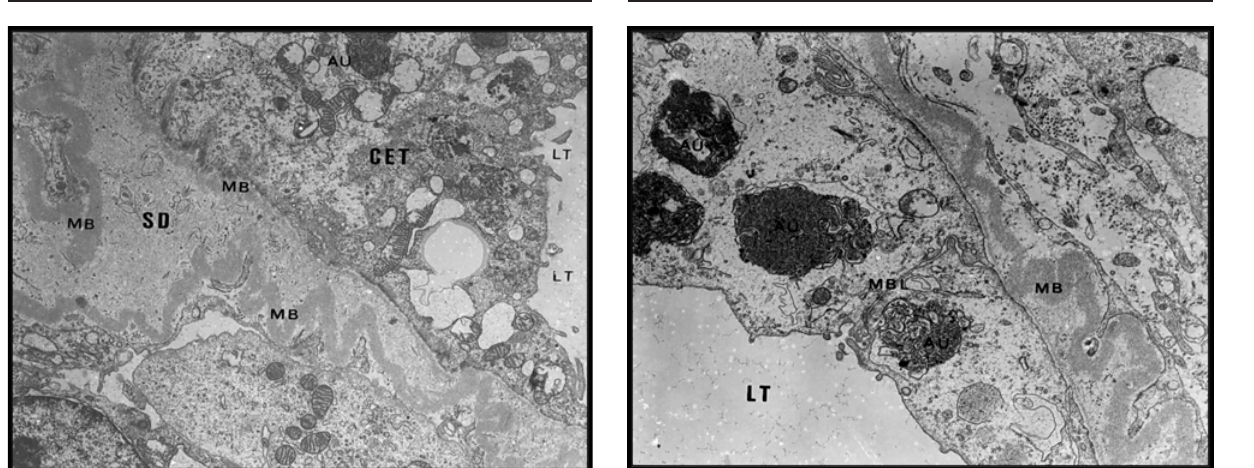
FIGURE 8 - Electronic photomicrography (9.450 X) of proximal tubule from the GI at the time 4 (28 days). The basal membrane is duplicated and markedly tortuous, with moderately electron- dense substance among the two layers.